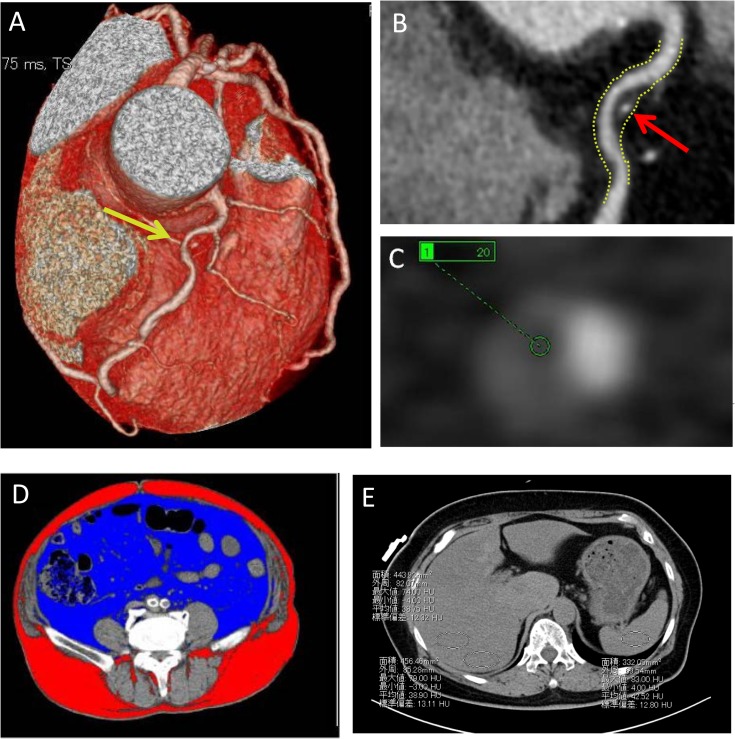
CT images of a coronary plaque, visceral adipose tissue, and liver.(A), Multidetector computed tomography imaging of a high-risk plaque with volume rendering; (B), curved multi-planar reconstruction image; and (C), an axial image. The yellow arrow in (A) denotes a high-risk plaque site. This lesion was positively remodeled as shown by comparison with a normal coronary segment proximal to the lesion (yellow dotted line in (B)). The red arrow in (B) denotes a region of spotty calcification, which is a low-density plaque of 20 HU. (D) CT of the liver of a patient with nonalcoholic hepatic steatosis. (E) CT image of a high area of visceral adipose tissue (220.4 cm2). Diffuse fat accumulation is observed in the liver in an unenhanced CT image with an L/S ratio of 0.74.